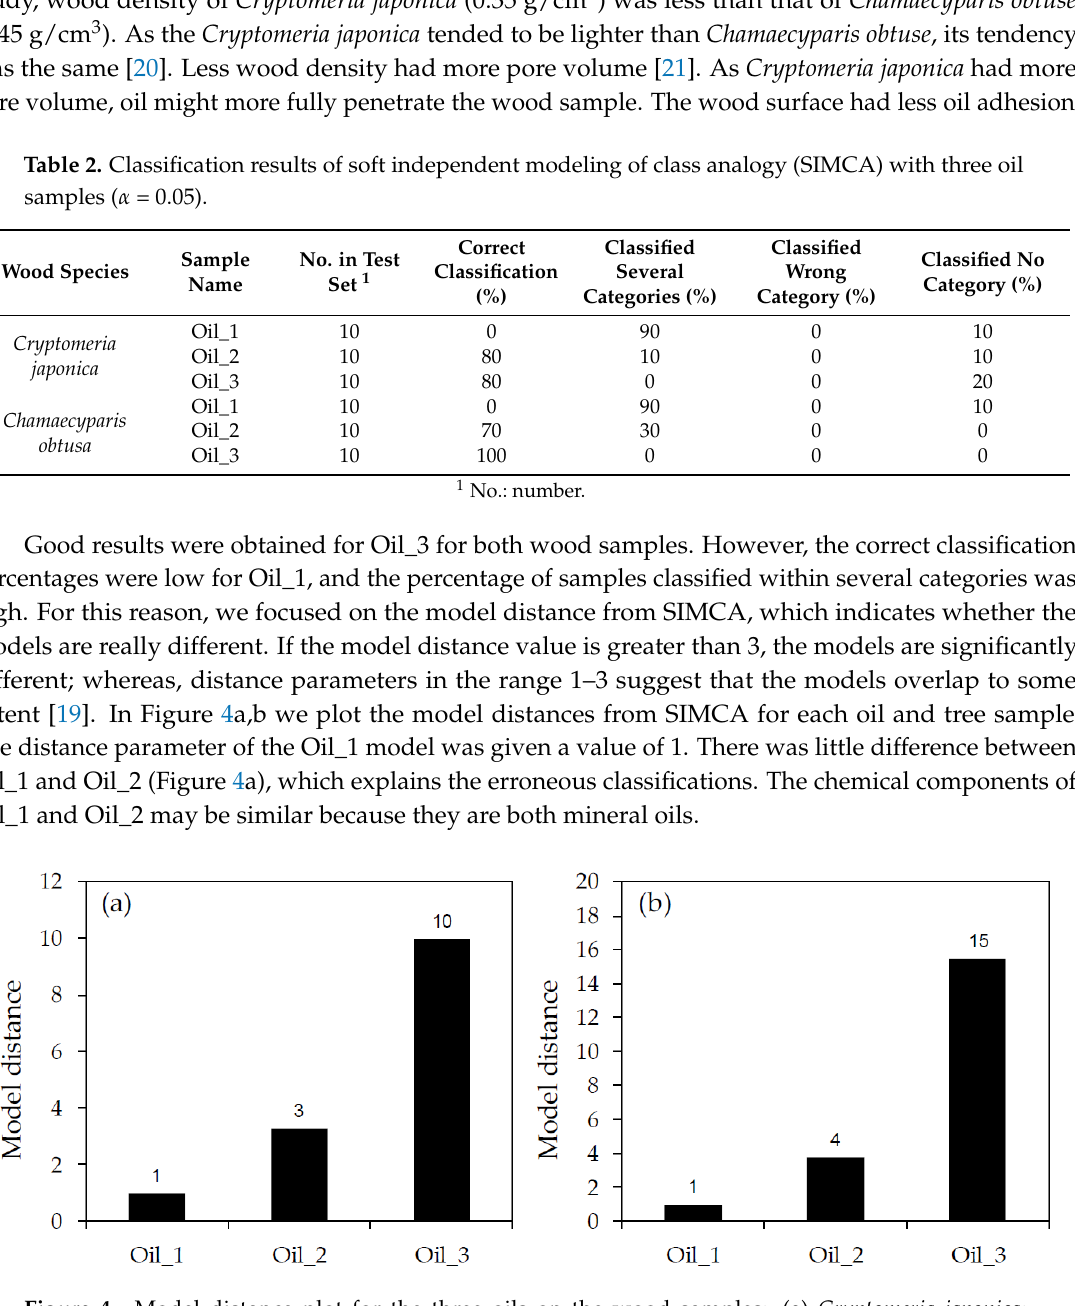
Table 2. Classification results of soft independent modeling of class analogy (SIMCA) with three oil samples ( α = 0.05).